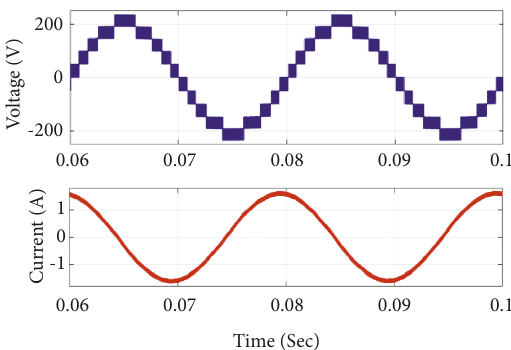
Figure 11: Output voltage and current (MI-0.99) and (MI-0.7).